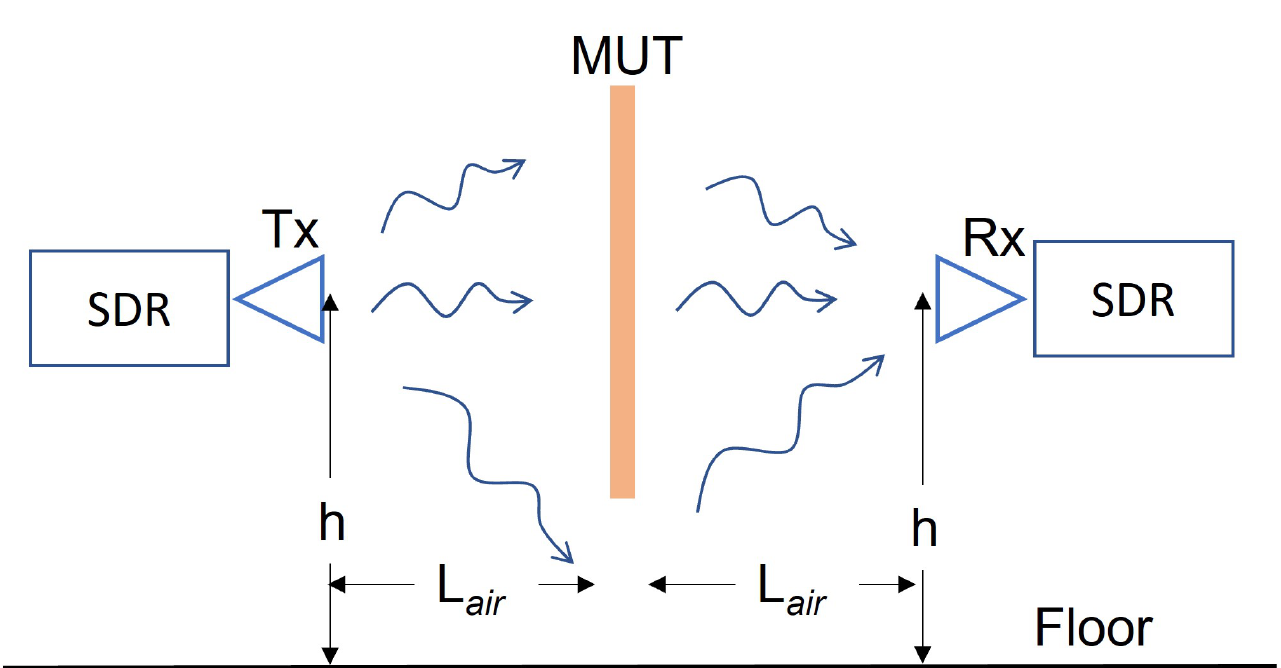
Figure 1. Sketch of the measurement configuration. The MUT is centered between the Tx and Rx antennae, at some distance from the